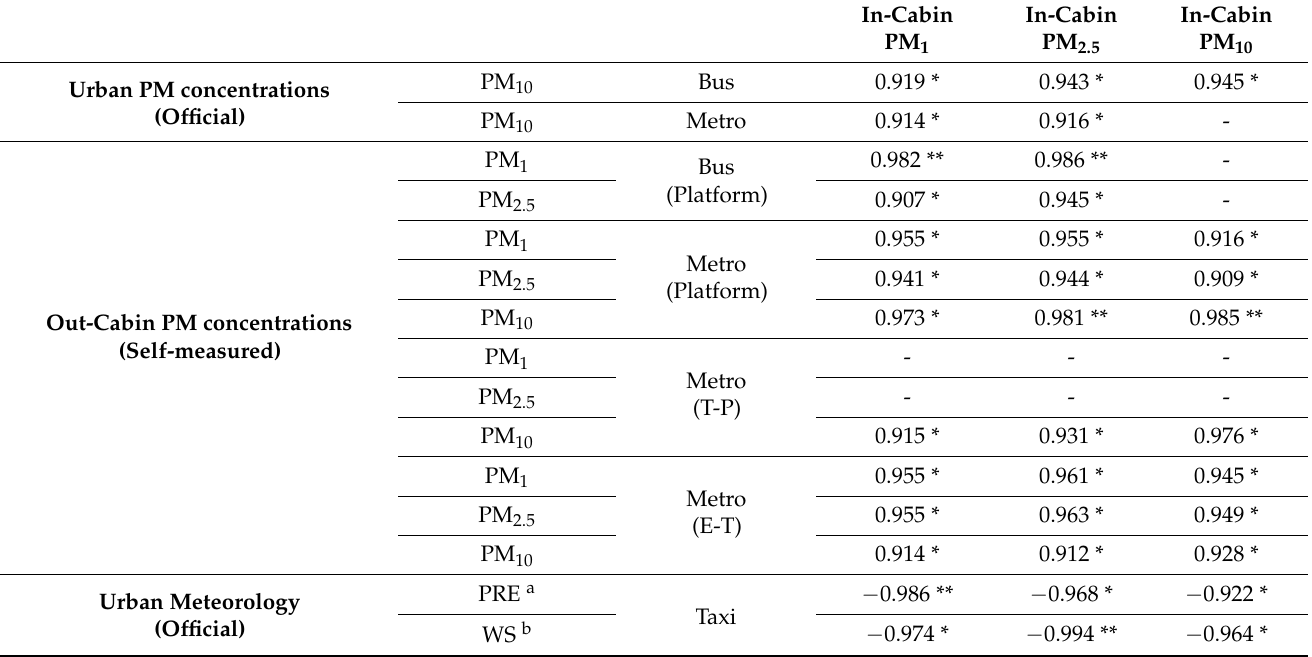
Table 6. Correlation coefficients of in-cabin particulate matter concentrations measured during the moving period and out-cabin and urban background environmental conditions compared by city.